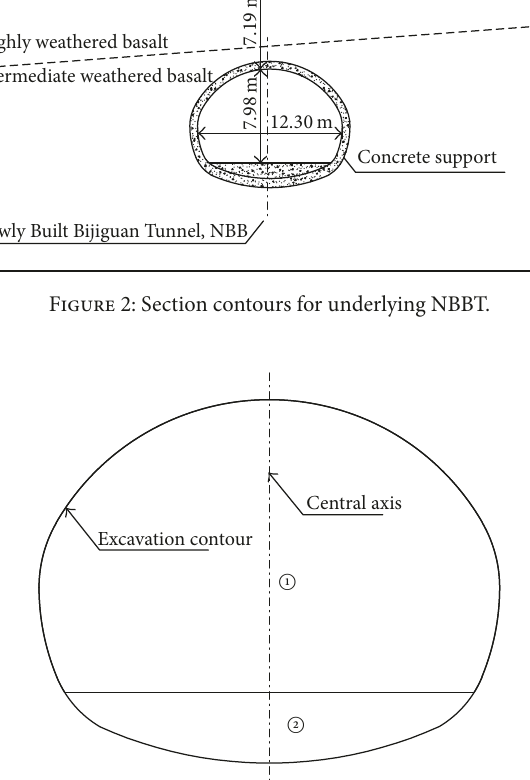
Figure 3: Full-face excavation contours for KS3 subway